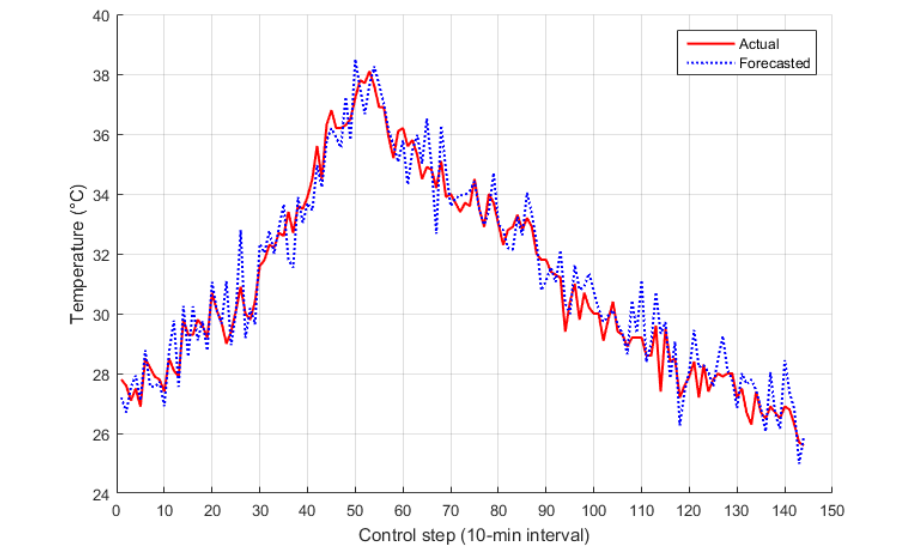
Figure 3. Actual and forecasted outdoor temperature.